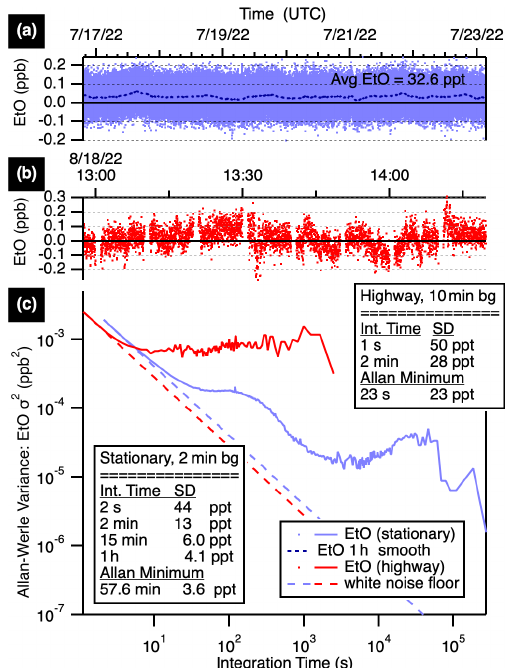
Figure 2. Time series (a, b) and Allan–Werle variance plots (c) showing EtO precisions at various averaging times while stationary with 2min autobackgrounds (blue) and while mobile on the high- way with 10min backgrounds (red). The stationary data (a) average to 32.6ppt EtO with a 1h smooth (dotted line)